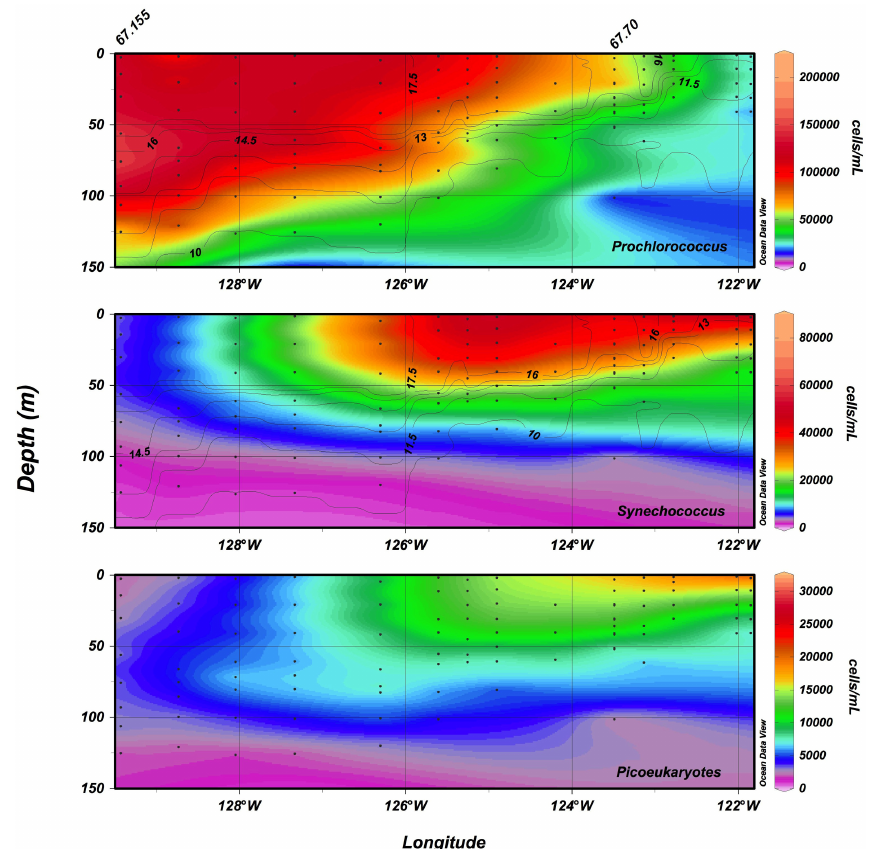
Fig. 2. Abundance of picocyanobacteria and Chl a -containing picoeukaryotes along CalCOFI Line 67. (a) Prochlorococcus , (b) Synechococ- cus , and (c) picoeukaryotes in cells permL, as determined by flow cytometry. Contours indicate water temperature in ◦ C. Sections made in Ocean Data View version 4.5 (http://odv.awi.de) using the VG gridding